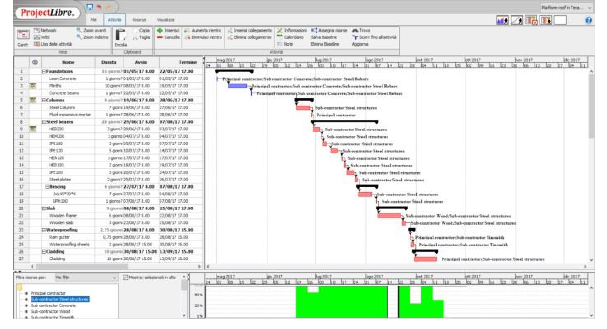
Figure 6. The Gantt diagram in ProjectLibre